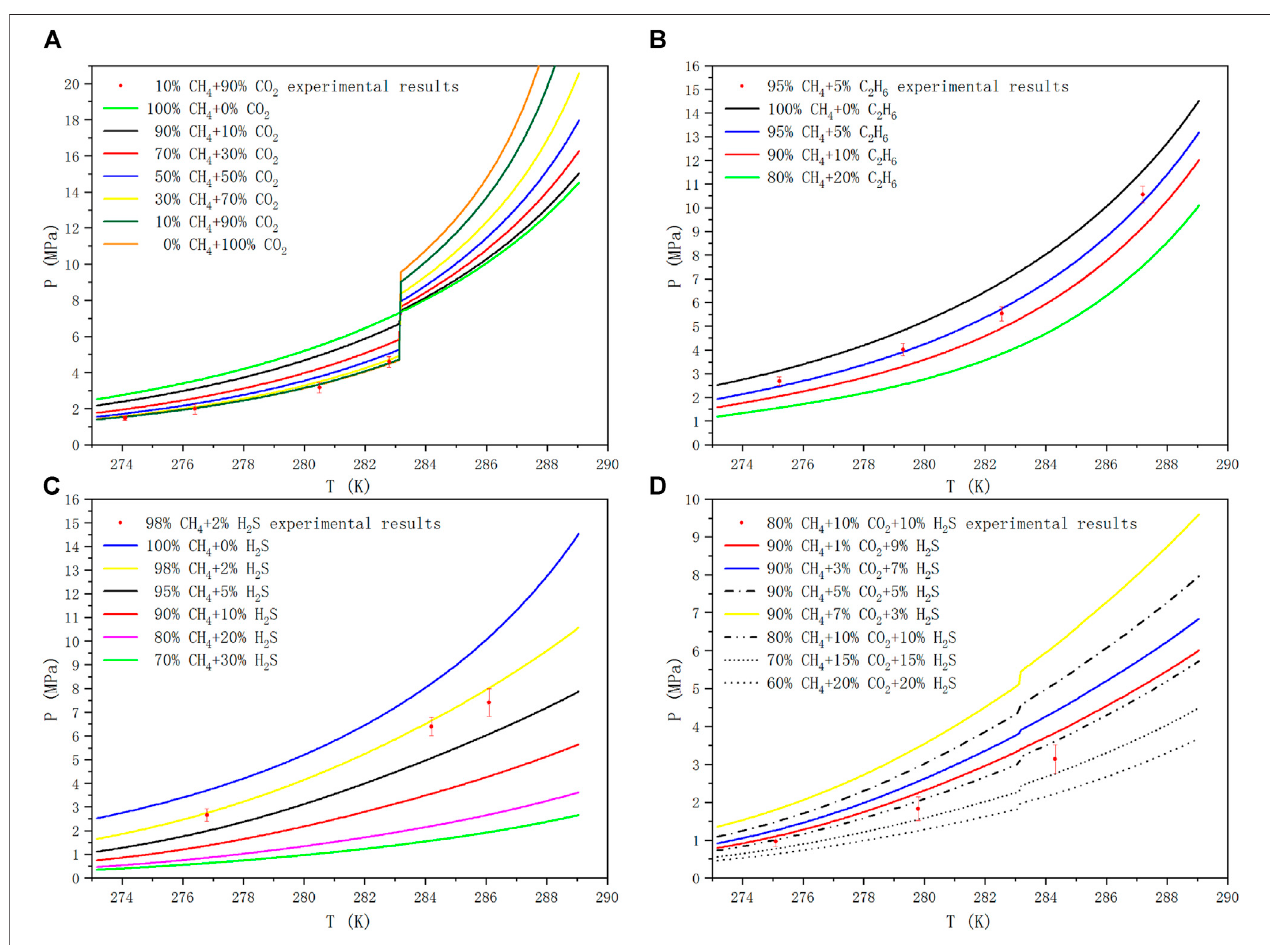
FIGURE 5 | Hydrate Phase equilibrium diagram of methane containing gases at different mole fraction ratios.